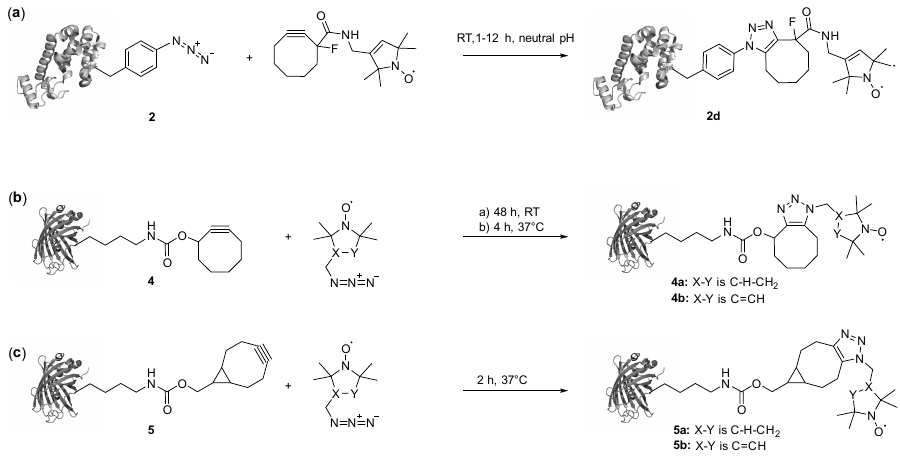
Figure 2. Overview of ncAA with reported use for SDSL. p -Acetyl- L -phenylalanine 1, p -azido- L - phenylalanine 2, N ε -propargyloxycarbonyl- L -lysine 3, N ε -Cyclooct-2-ynyloxycarbonyl- L -lysine 4, N ε -Bicyclo[6.1.0]non-2-yn-9-ylmethoxycarbonyl- L -lysine 5, N ε -1-oxy-2,2,5,5-tetramethylpyrroline- 3-ylmethoxycarbonyl- L -lysine 6.